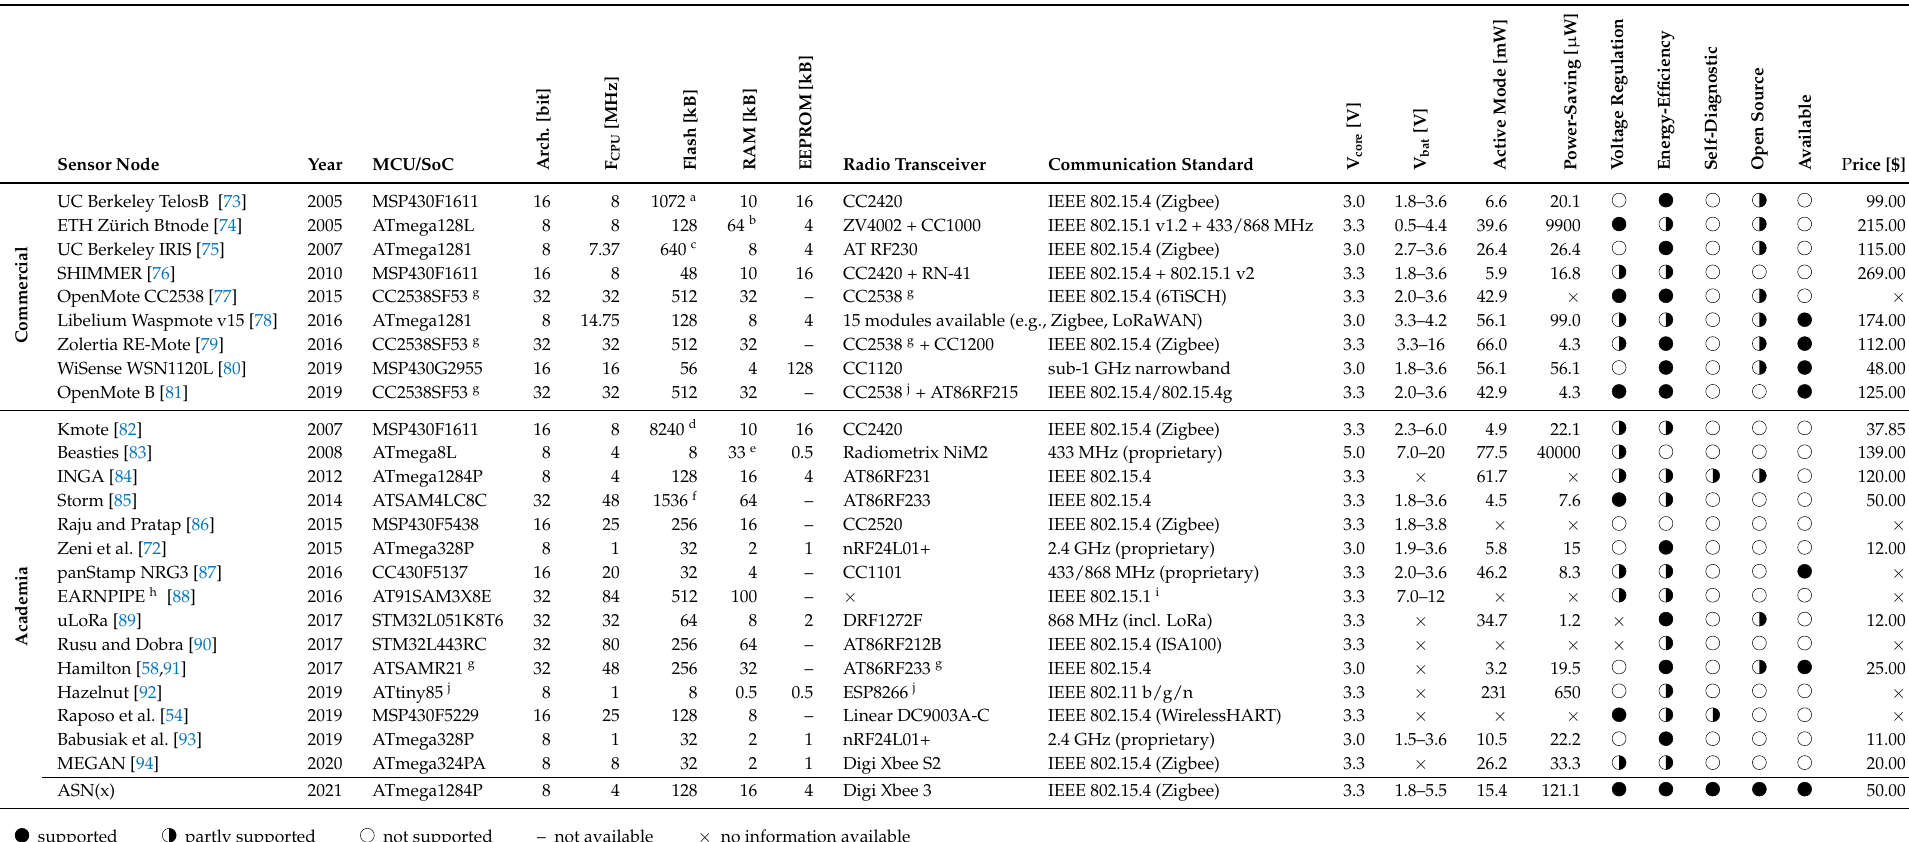
Table 1. Overview of the characteristics of WSN